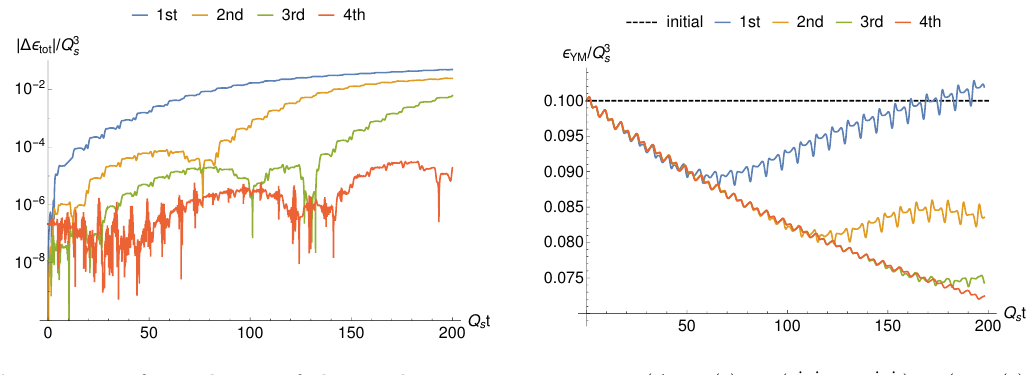
Figure 6 . Left: violation of the total energy conservation ((cid:1) (cid:15) (cid:15) hol ( t )) + (cid:15) xc ( t )) as function of time in four subsequent iterations for (cid:12) = 0 : 2 ; g YM = p Q s = 0 : 5 ; (cid:15) ini =Q 3 = 0 : 1, and (cid:15) ini =Q 3 = 1 = 250. Right: time evolution of the energy in the Yang-Mills s s YM hol sector for the same parameters in four subsequent